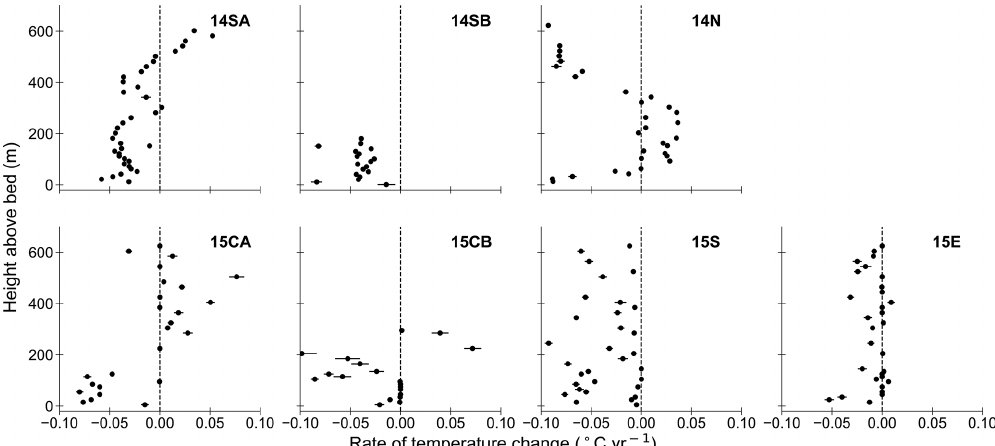
Figure 3. Rates of temperature changes for each borehole plotted against each sensor’s height above the bed. Boreholes drilled in 2014 show trends between July 2015 and July 2017, while temperature trends in boreholes drilled in 2015 represent temperature changes observed between July 2016 and July 2017. Error bars indicate 2 standard errors from the mean rate, determined by the linear regression.